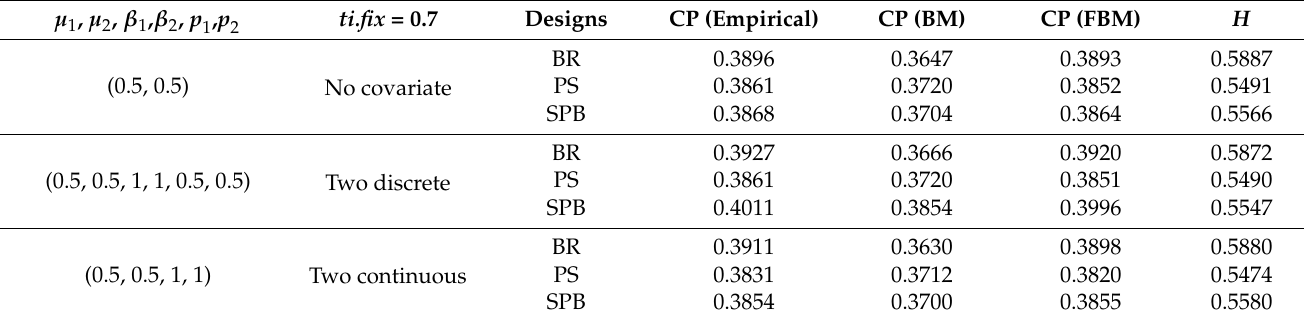
Table 4. CPs under misspecification scenarios: ε ’s ~increments of FBM, H = 0.9, drift = 1.